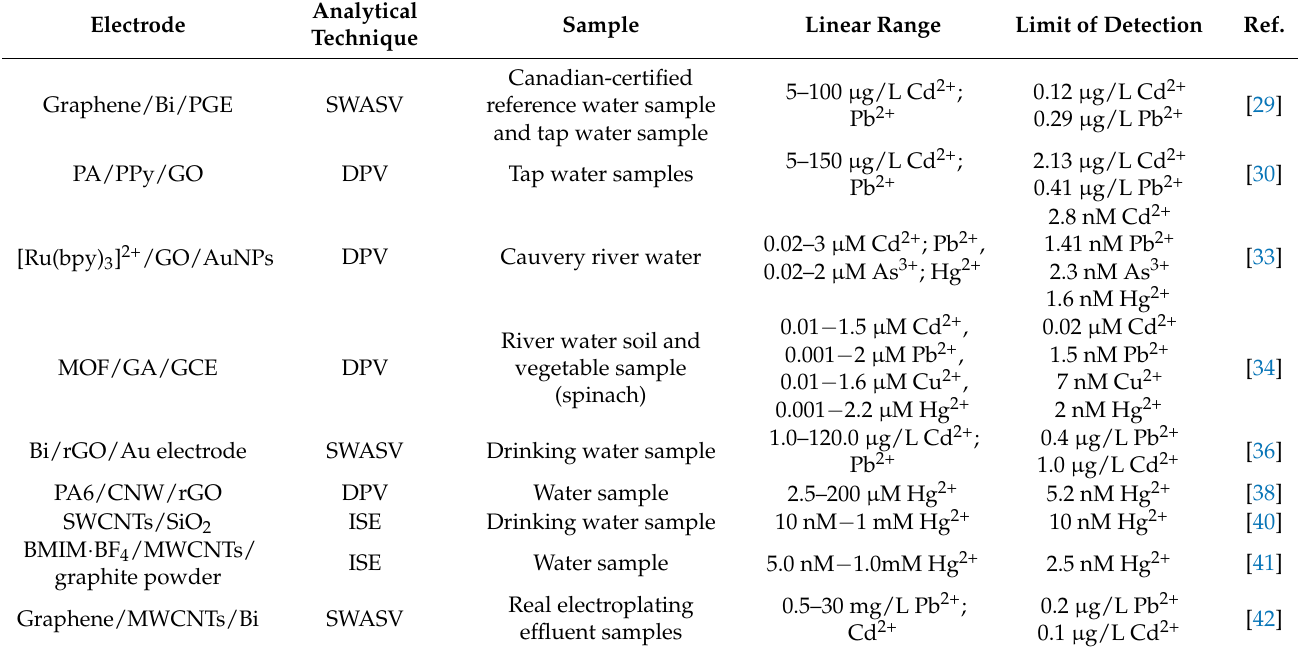
Table 2. Representative studies of electrochemical analysis of heavy metals from food and water resources by nanosensors.